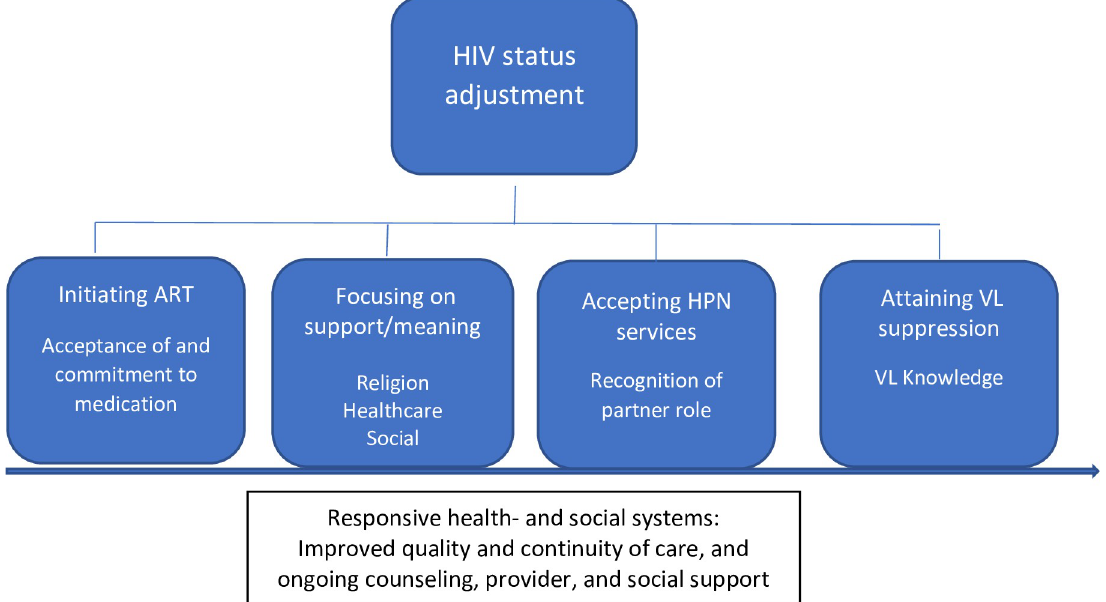
Fig 3. Conceptual model to facilitate HIV status acceptance by newly diagnosed patients with acute or chronic HIV infection and their primary partners.